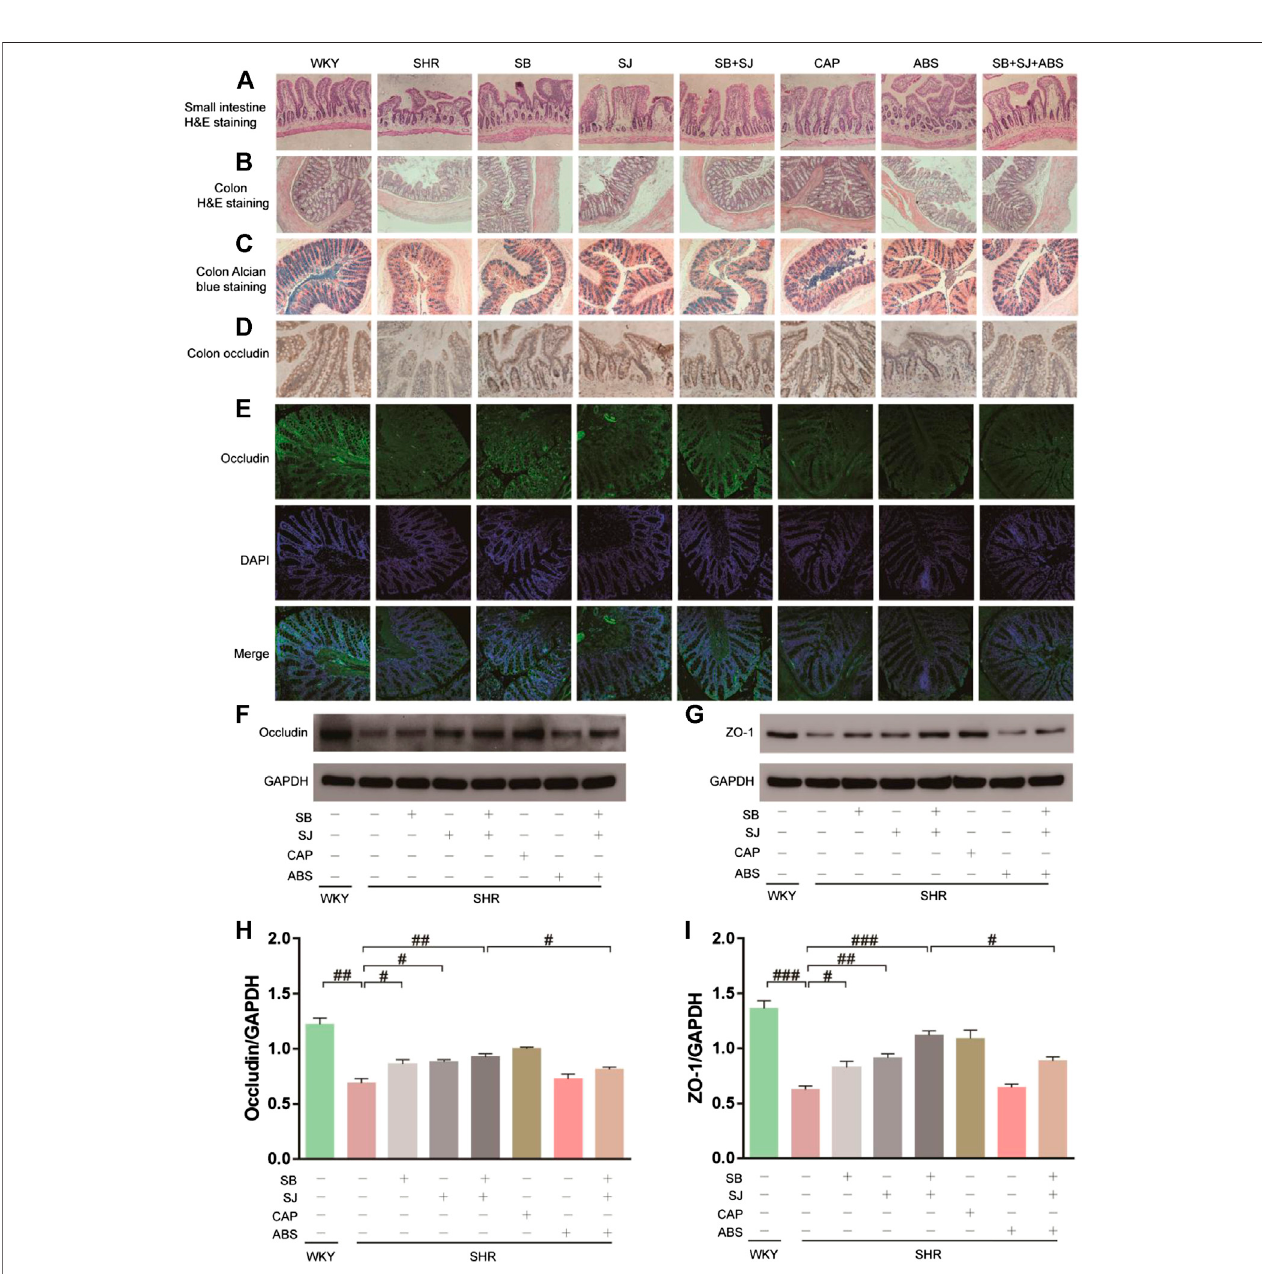
FIGURE 5 | Histological changes showing restoration of the small intestine and colon and gut barrier dysfunction by the combination of SB and SJ in SHR. (A) HE staining of the small intestine. The representative images were taken from the gut tissue slides (Magni fi cation, 10 × ). (B) HE staining of colon tissue (Magni fi cation, 10 × ). (C) Alcian blue staining of goblet cells. (D) IHC staining of occludin in colon tissue; the dark brown staining indicates a positive stain by occludin. (E) The immuno fl uorescence staining of occludin in colon tissue (Magni fi cation, 20 × ). (F – I) Western blotting results of occludin, ZO-1, and their respective quanti fi cation in the colon. Data are presented as mean ± SD. ### p < 0.001. ## p < 0.01. # p <